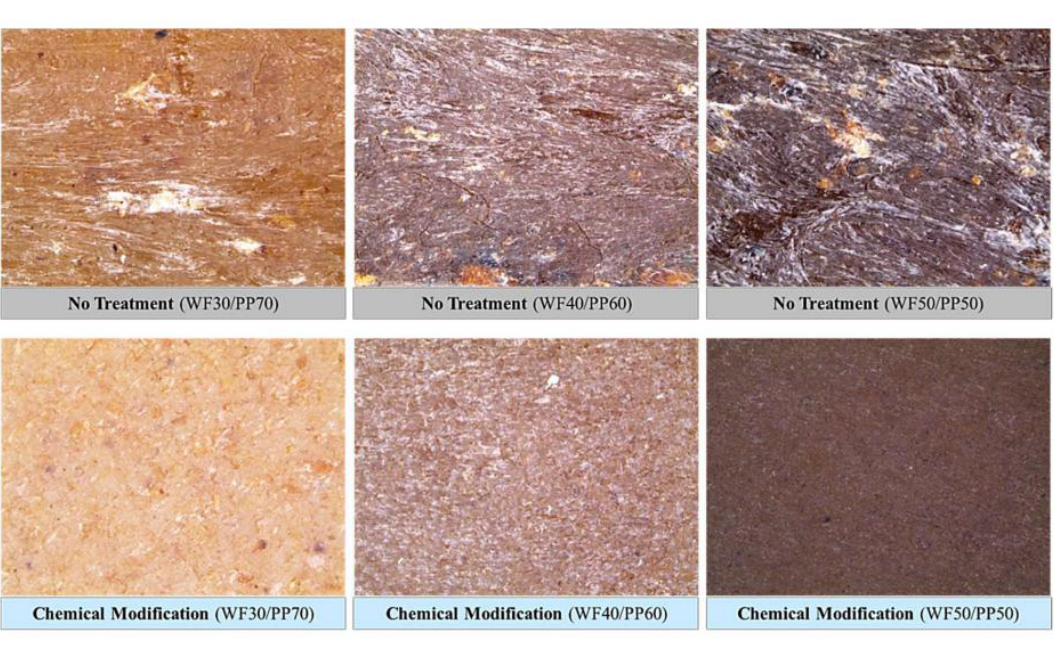
Figure 15. Stereomicroscope observation (magnification: 80 × ) of chemically modified and untreated wood-plastic composite injection-molded ASTM